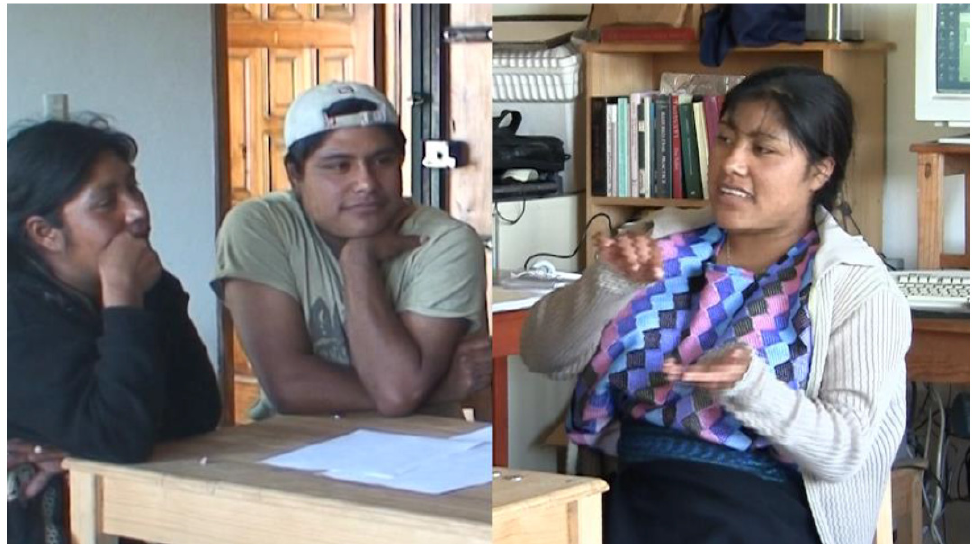
Figure 5. Terry begins her signed turn, gazing at her interlocutors.